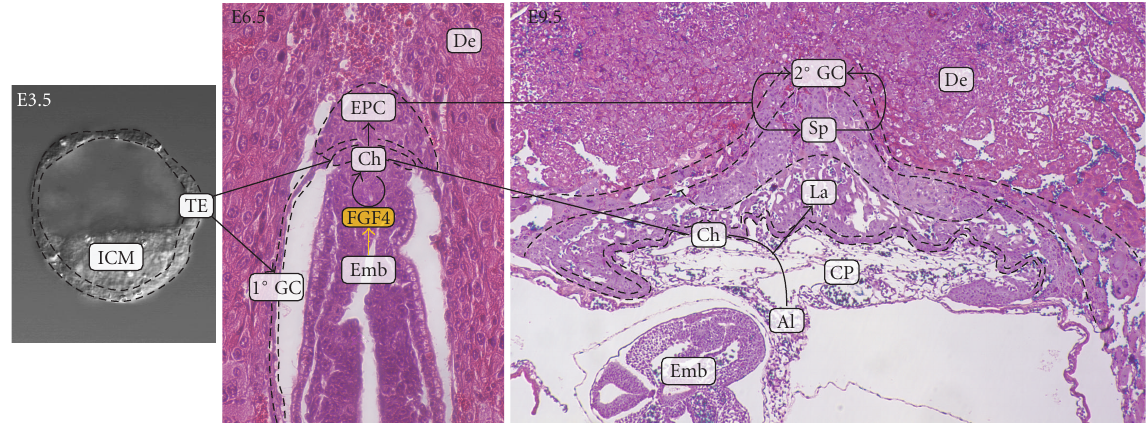
Figure 1: Trophoblast lineages in the developing mouse placenta. Shown from left to right are a blastocyst (E3.5), an E6.5 embryo, and an E9.5 embryo. Respective trophoblast lineages are traced for clarity. Al: allantois; Ch: chrion; CP: chorionic plate; De: decidua; Emb: embryo; EPC: ectoplacental cone; 1 ◦ GC: primary giant cells; 2 ◦ GC: secondary giant cells; ICM: inner cell mass; La: labyrinth; Sp: spongiotrophoblast; TE: trophectoderm. FGF4: fibroblast growth factor 4 secreted by the embryo to maintain the chorion. Blastocyst and E6.5 embryo picture courtesy of Drs. Mimi DeVries and Tom Gridley, respectively, The Jackson